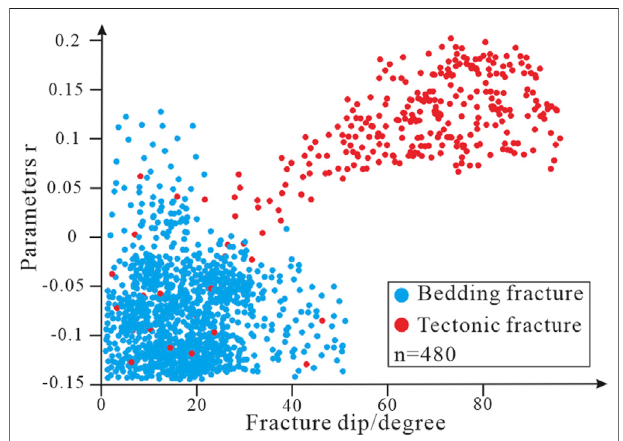
FIGURE 6 | Relationship between dual lateral logging parameter r and fracture dip angle of Lucaogou